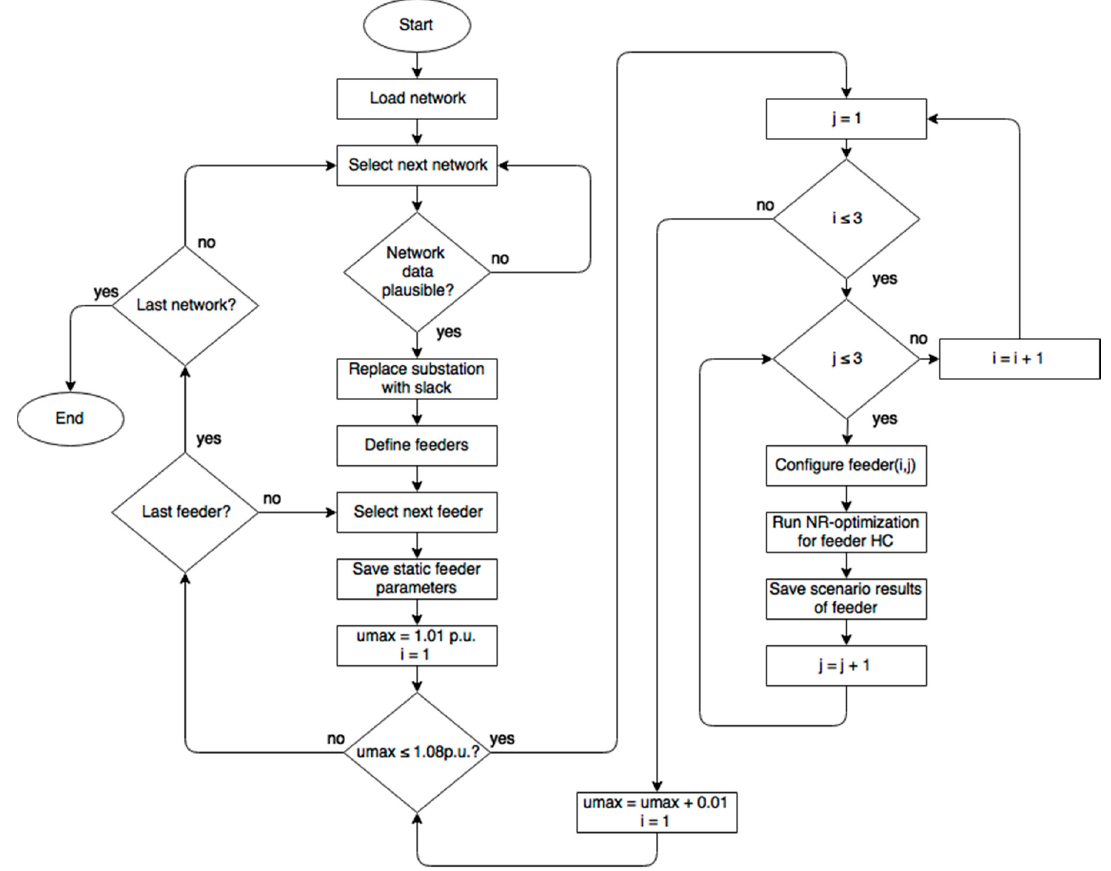
Figure 6. Algorithm to calculate the feeder hosting capability (HC) for different.